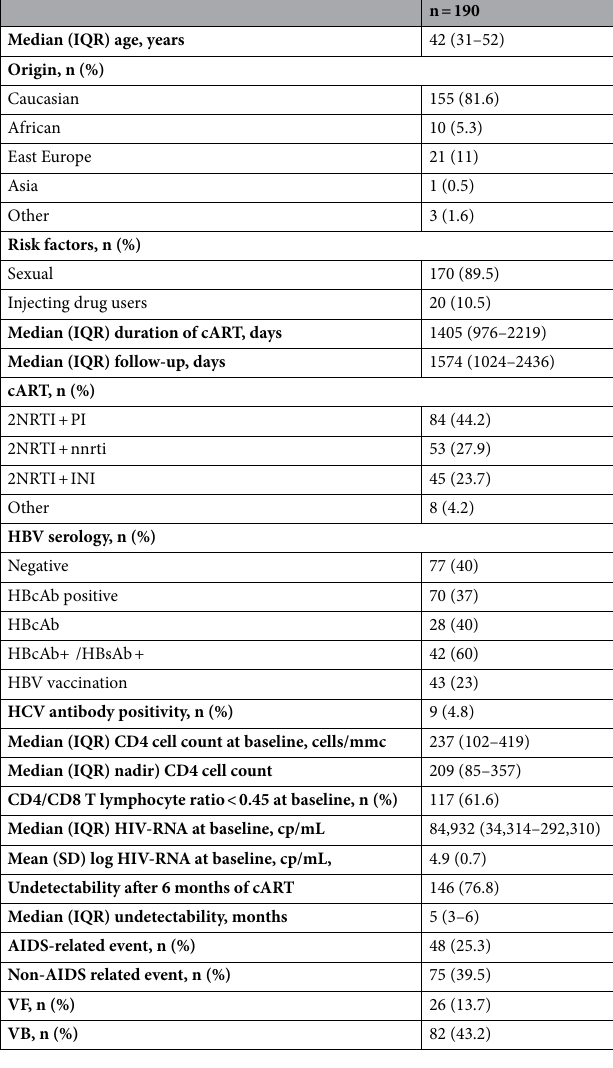
Table 1. Descriptive analysis. VB = viral blip, single detection of HIV-RNA > 50 cp/mL; VF = viral failure, two consecutive HIV-RNA ≥ 50 cp/mL or one > 1000 cp/mL with consequent change of cART. cART = combined antiretroviral therapy; NRTI = nucleoside/nucleotide reverse transcriptase inhibitor; NNRTI = nonnucleoside reverse-transcriptase inhibitors; PI = protease inhibitors; undetectability = HIV-RNA < 50 copies/mL. AIDS- related events = the occurrence of any opportunistic infections or malignancy according to the World Health Organization (ref. 20); non-AIDS-related events = comorbidities such as hypertension, diabetes and lipidic disorders, bone disorders (osteopenia, osteoporosis), renal impairment and non-AIDS-related neoplastic